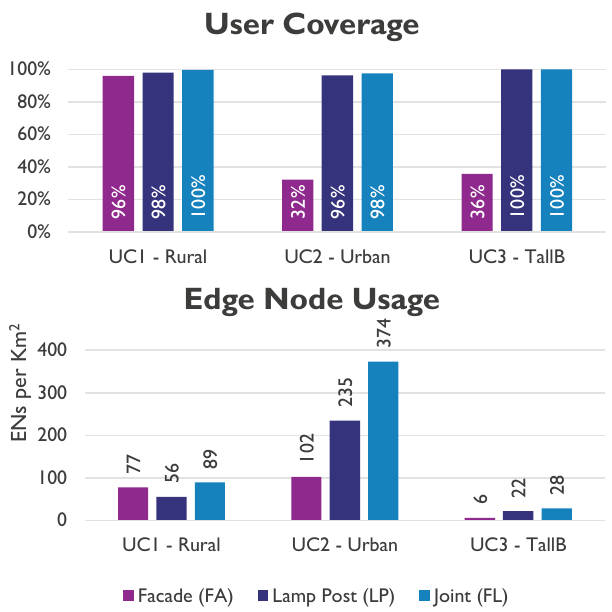
Figure 13. Use case comparison of coverage and network